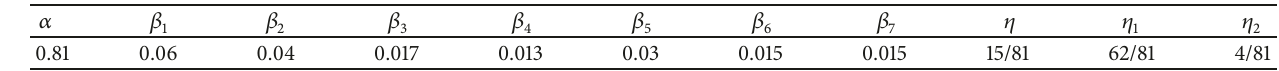
Table 11: Weight percentage of each item.